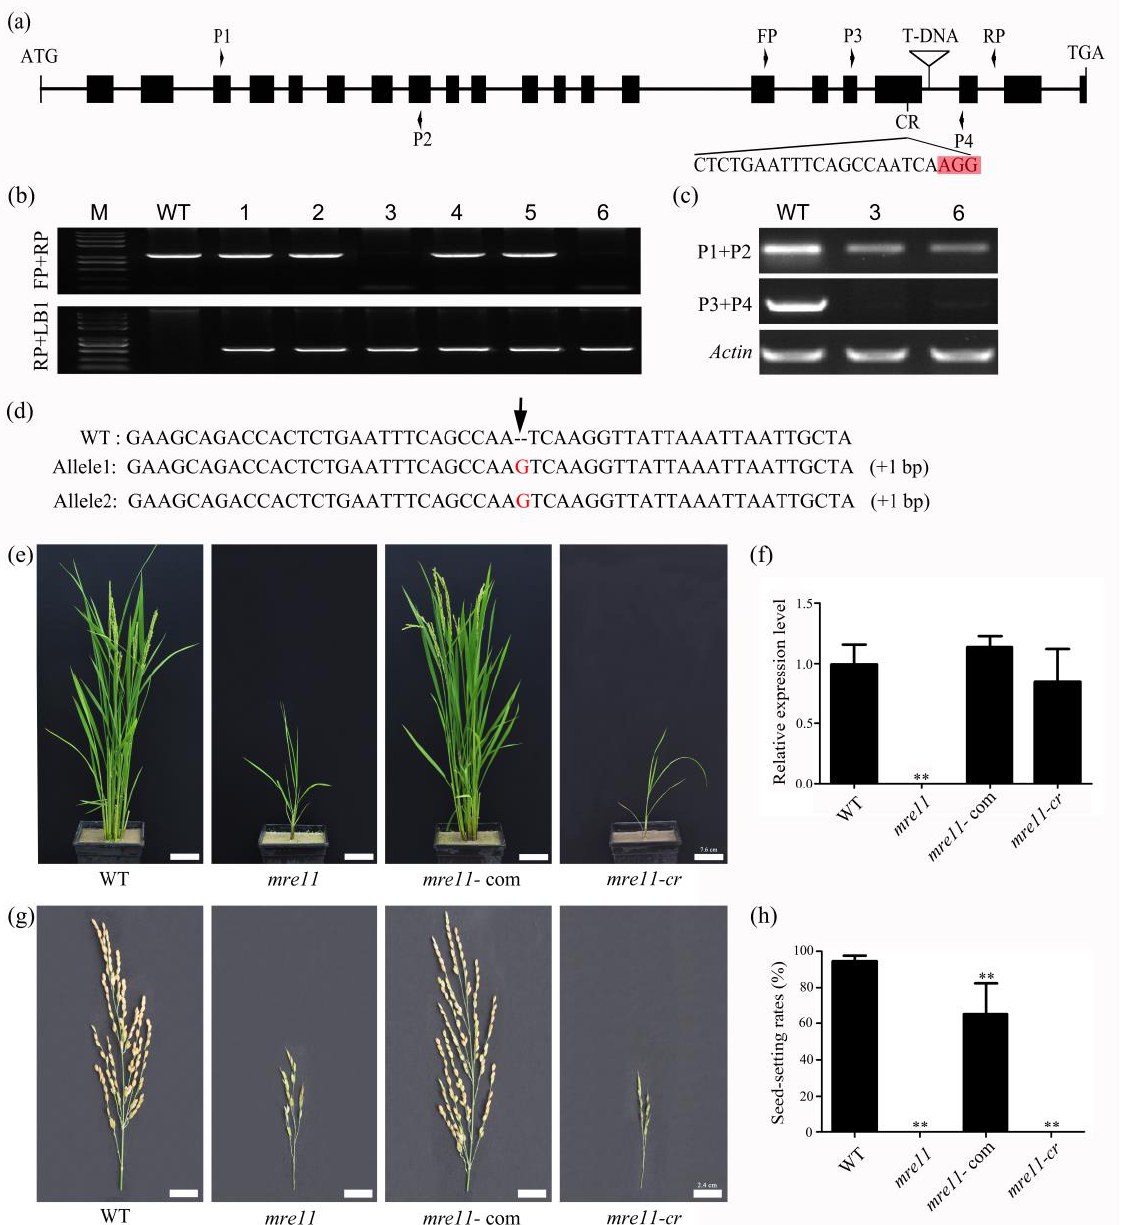
Figure 2. Identification and phenotypic characteristics of the mre11 mutant in rice. Identification and phenotypic characteristics of the mre11 mutant in rice. ( a ) Schematic diagram of the Mre11 gene in rice shows the positions of T-DNA insertion and CRISPR/Cas9 (clustered regularly interspaced short palindromic repeats/Cas9) editing site. Exons are depicted as black box; while introns are depicted as lines. Red rectangle highlights the CRISPR/Cas9 editing site protospacer adjacent motif sequence. ( b ) Identification of the homozygous and heterozygous mre11 mutants by assay method of three primers. ( c ) Semiquantitative analysis of Mre11 gene in the number 3 and 6 of rice plants. ( d ) Sequence analysis of Mre11 mutation site in the mre11-cr plant. An arrow indicates the location of genetic editing site, inserting a base G. ( e ) Phenotypes of wild-type plant (WT), mre11 mutant plant, complemented plant ( mre11 -com), and CRISPR/Cas9 transgenic plant ( mre11-cr ). Scale bars represent 7.6 cm. ( f ) Relative expression level of OsMre11 gene in WT, mre11 , mre11- com, and mre11-cr plants. ( g ) Panicle phenotypes of WT, mre11 , mre11- com, and mre11-cr plants. Scale bars represent 2.4 cm. ( h ) The average seed-setting rates of each panicle in WT, mre11 , mre11- com, and mre11-cr plants. The numbers of panicles are more than 24. The two asterisks represent a statistically significant difference according to Student’s t -test (**, p < 0.01).